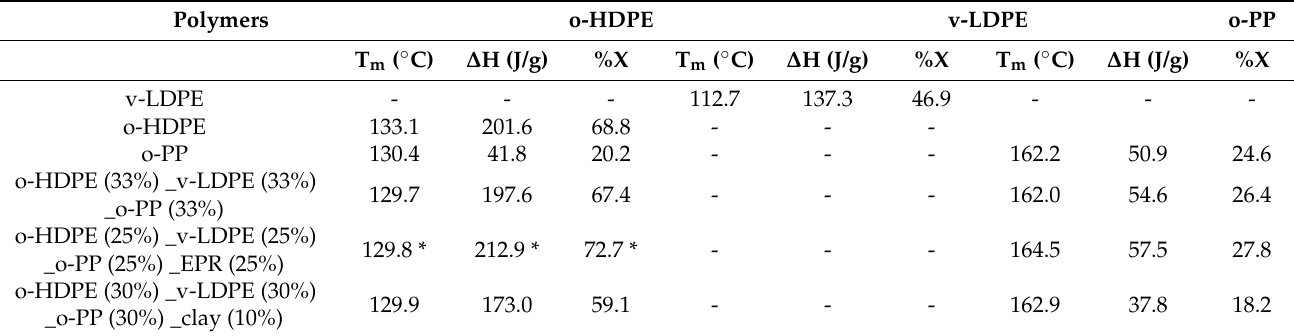
Table 2. Thermal transition properties (including melting temperature, enthalpy of melting, and crystallinity) of polymer blends composed of o ‐ HDPE, v ‐ LDPE, and o ‐ PP (from the second heating curve of DSC).